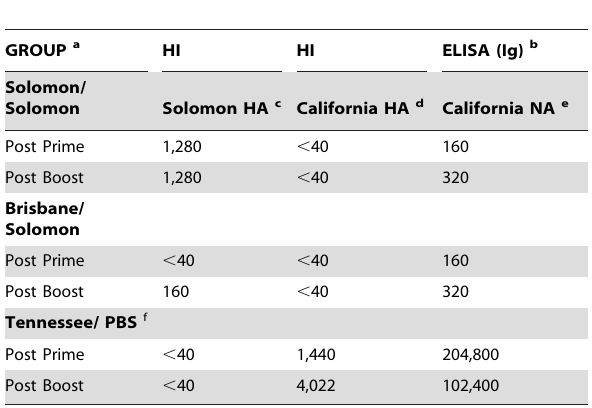
Table 2. Serum antibody titers in Balb/c mice after prime or boost with wild-type viruses as determined by hemagglutination inhibition and ELISA